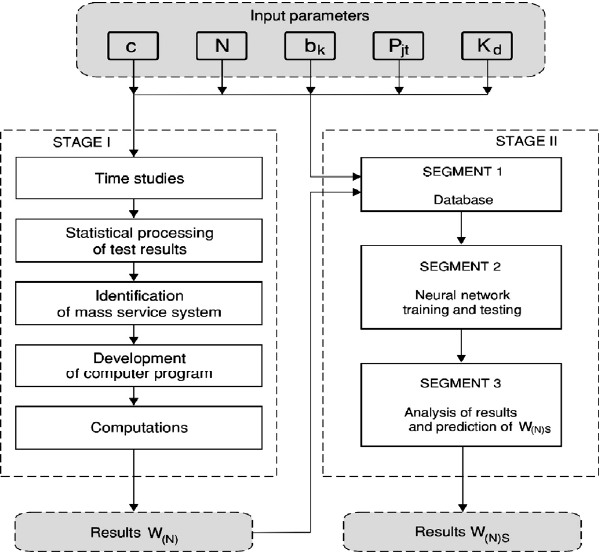
Fig 1 . Schema of research methodology MSS: M/M/c/FIFO/N is the adopted mass service system (queuing system) code (1).